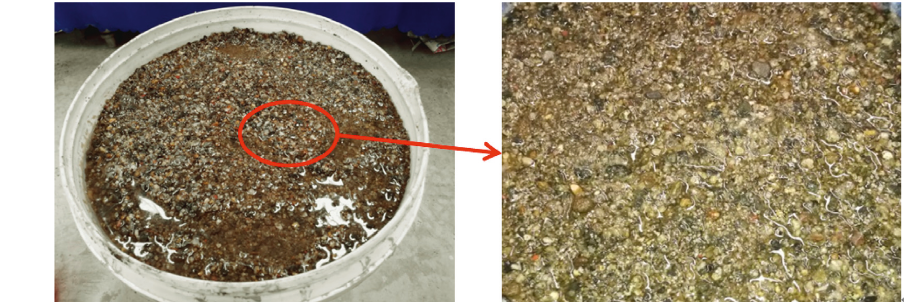
Figure 4: Remolding the supersaturation of medium sand. Table 2: Sodium bentonite-CMC mixed mud ratio